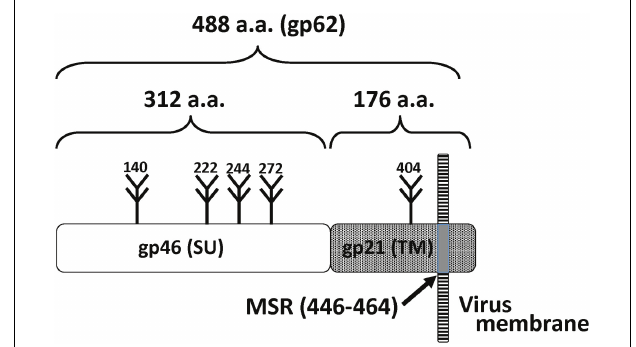
FIGURE 2 | Organization of Env proteins. The surface unit (SU) gp46 and transmembrane unit (TM) gp21 and are shown. Five potential N-glycosylation sites and the membrane-spanning region (MSR) are